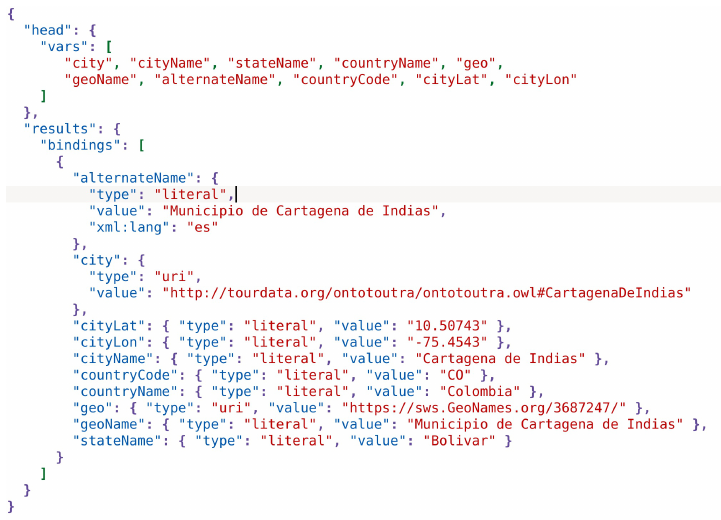
Figure 7. Results of data link to GeoNames for obtaining city